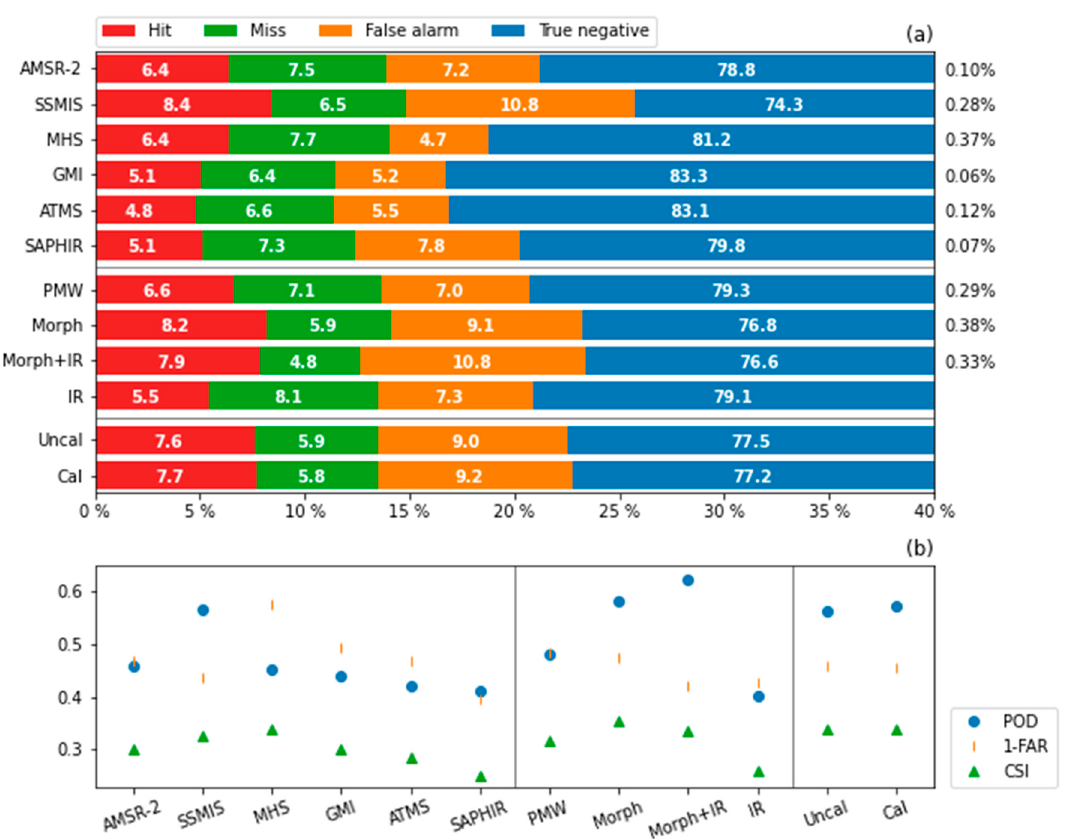
Figure 4. Detectability of precipitation events for 12 IMERG estimates verified against the China Merge Precipitation Analysis hourly V1.0 product (CMPA) product ( a ) Hit, miss, false alarm, and true negative fractions in percentage. The right column of proportion indicates the sampling weights in the corresponding “PMW” or “Uncal” data. ( b ) Three categorical indices, probability of detection (POD), false alert ratio (FAR), and critical successful index (CSI), for 12 IMERG estimates.